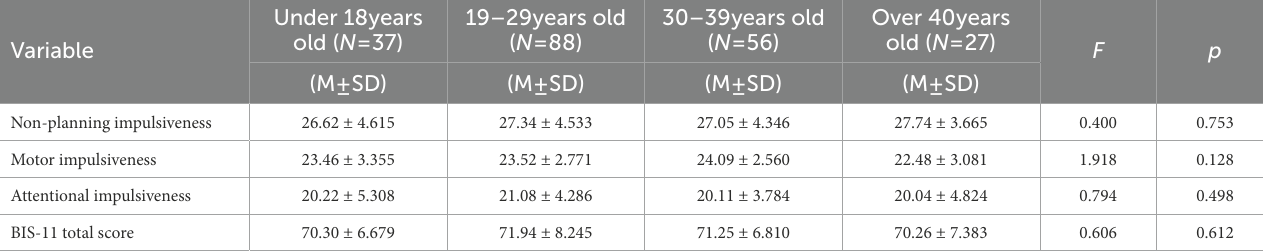
TABLE 2 Age difference test of trait impulsivity.